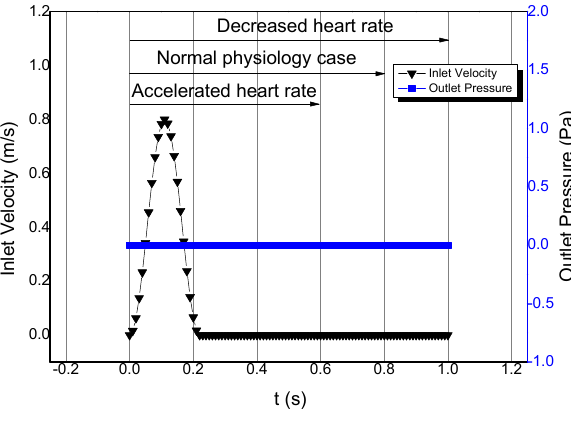
Figure 4. Boundary condition of the flow field.